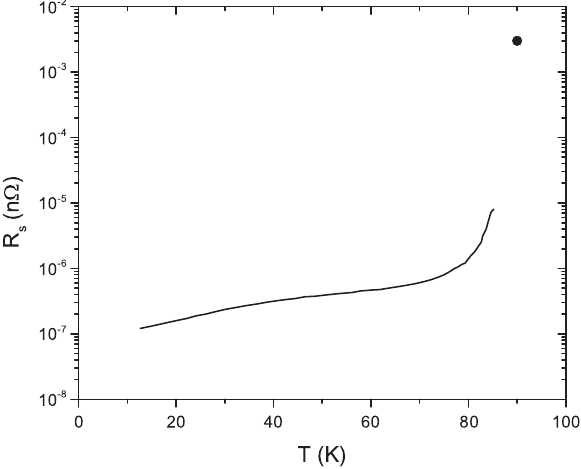
FIG. 16. Temperature dependence of the surface resistance of YBCO films scaled to 750 MHz from values measured at 8 GHz [33]. The solid symbol is the surface resistance of Cu at 90